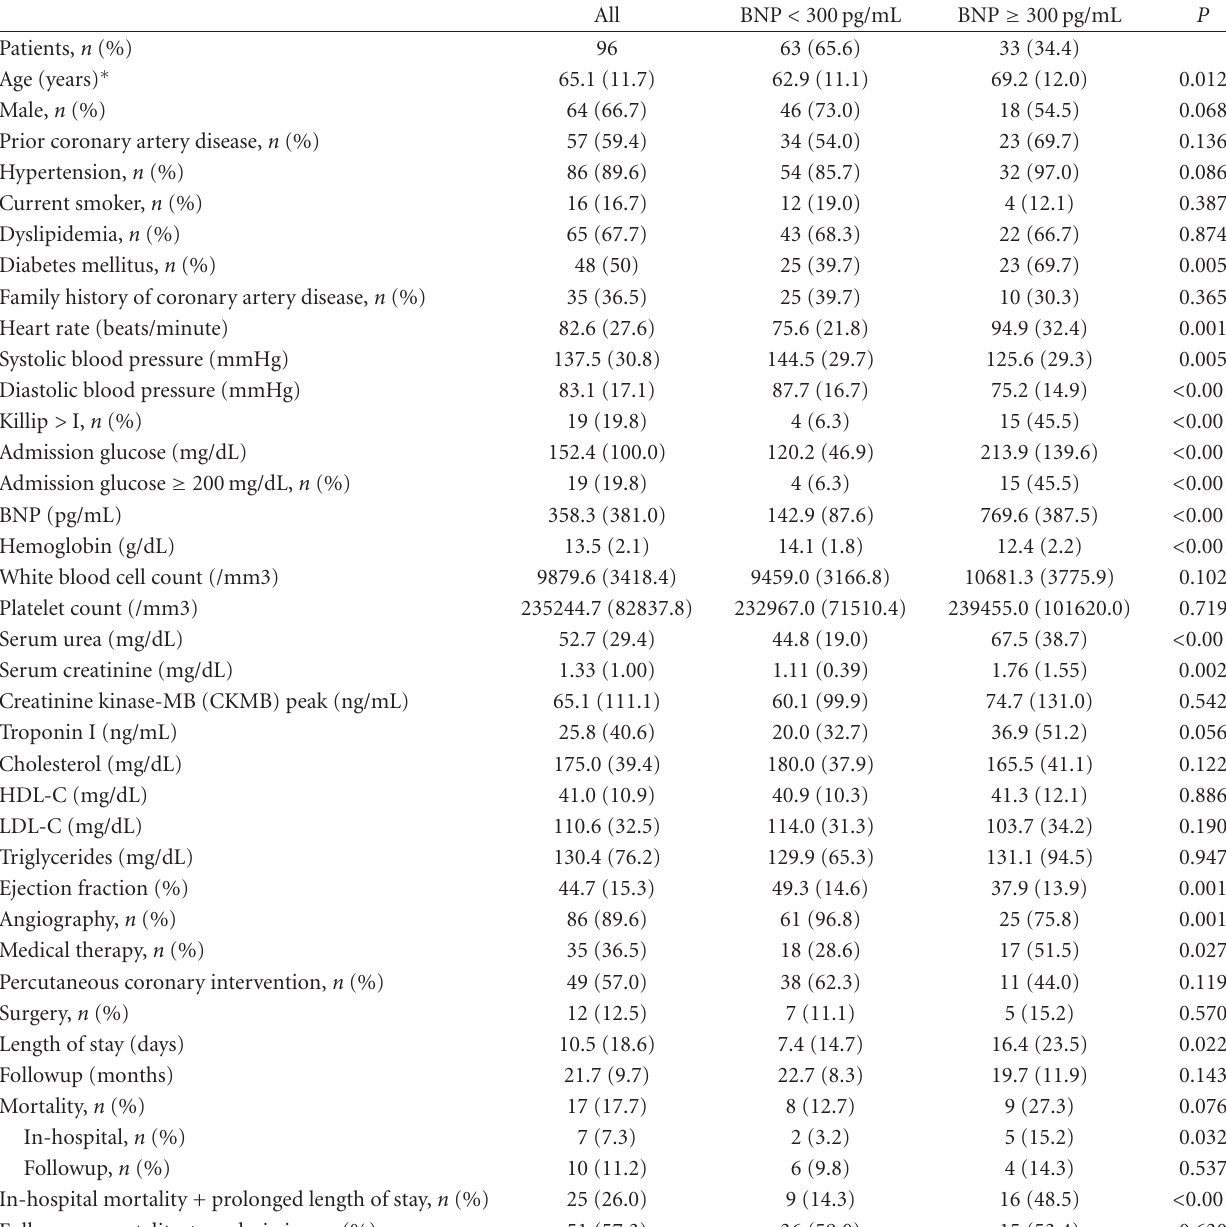
Table 2: Clinical and demographic patient characteristics, grouped by BNP ≥ or < 300